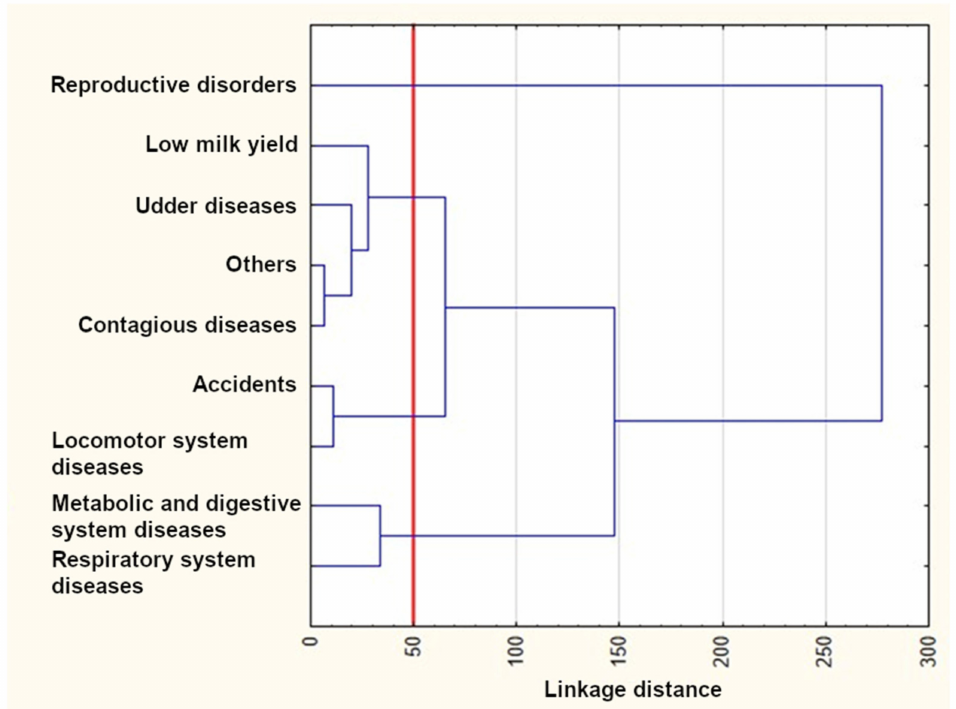
Figure 6. The results of the cluster analysis using Ward’s method for the first, second, and third